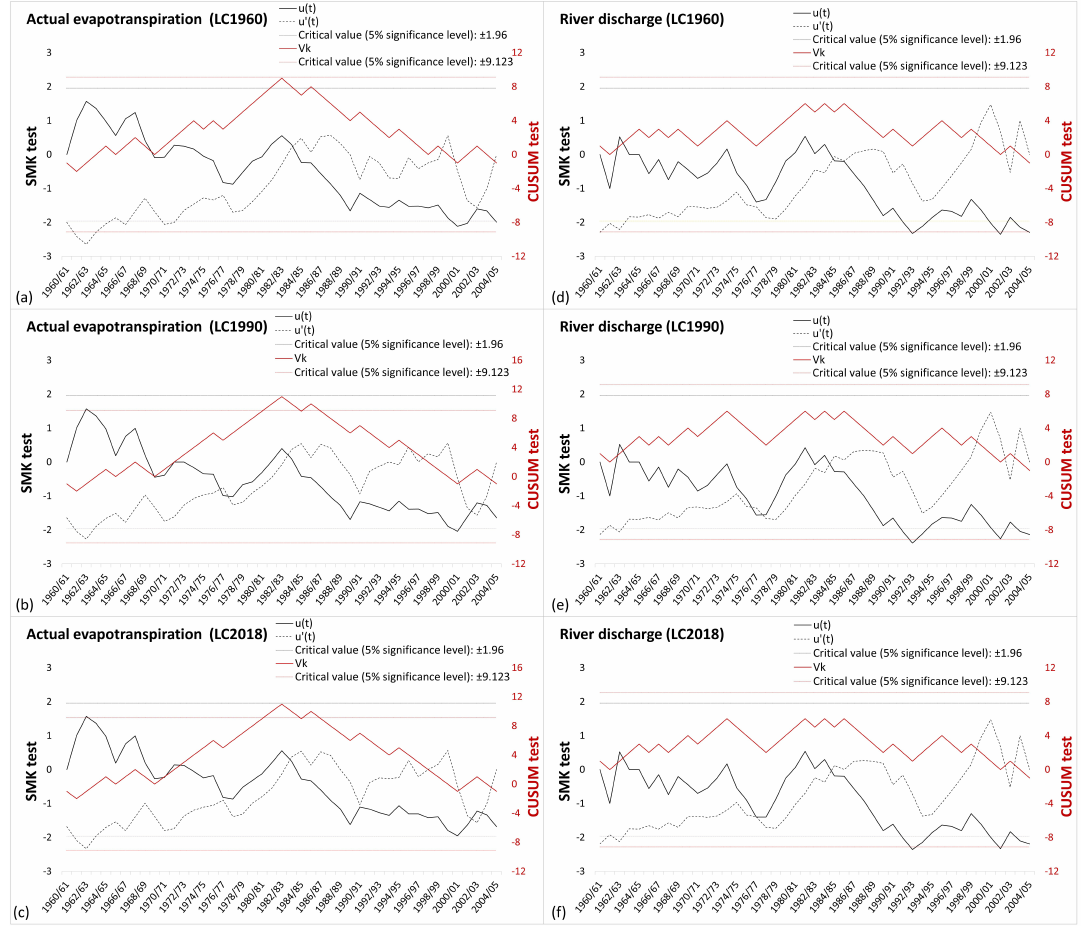
Figure 12. SMK and CUSUM tests for actual evapotranspiration for ( a ) LC1960, ( b ) LC1990, and ( c ) LC2018, and river outflow to Maliakos Gulf for ( d ) LC1960, ( e ) LC1990, and ( f ) LC2018. Climate 2019 , 7 , x FOR PEER REVIEW